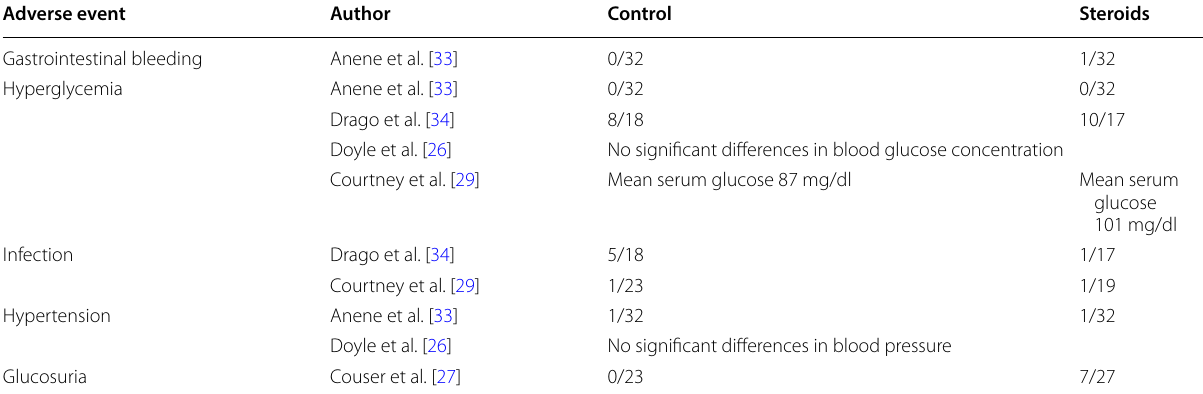
Table 1 Adverse events reported as potentially attributable to